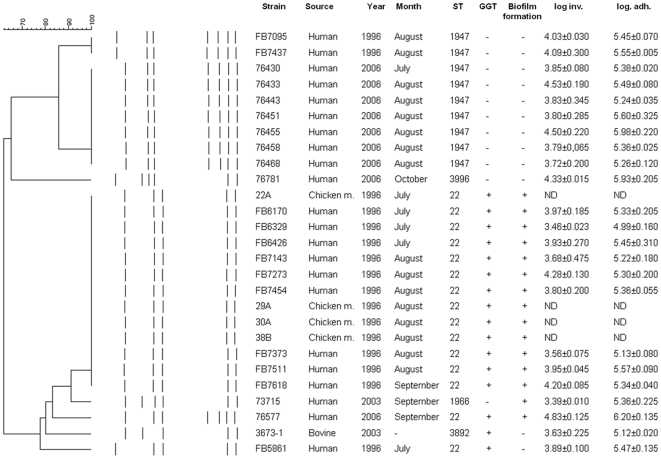
Phenotypic and genotypic characteristics of the 27 strains of Campylobacter jejuni of the ST-22 complex.Distribution of SmaI digested PFGE patterns, GGT production, biofilm formation and invasion and adhesion on HeLa cells (expressed in log CFU/ml) of the strains are shown. ND: Not Done.